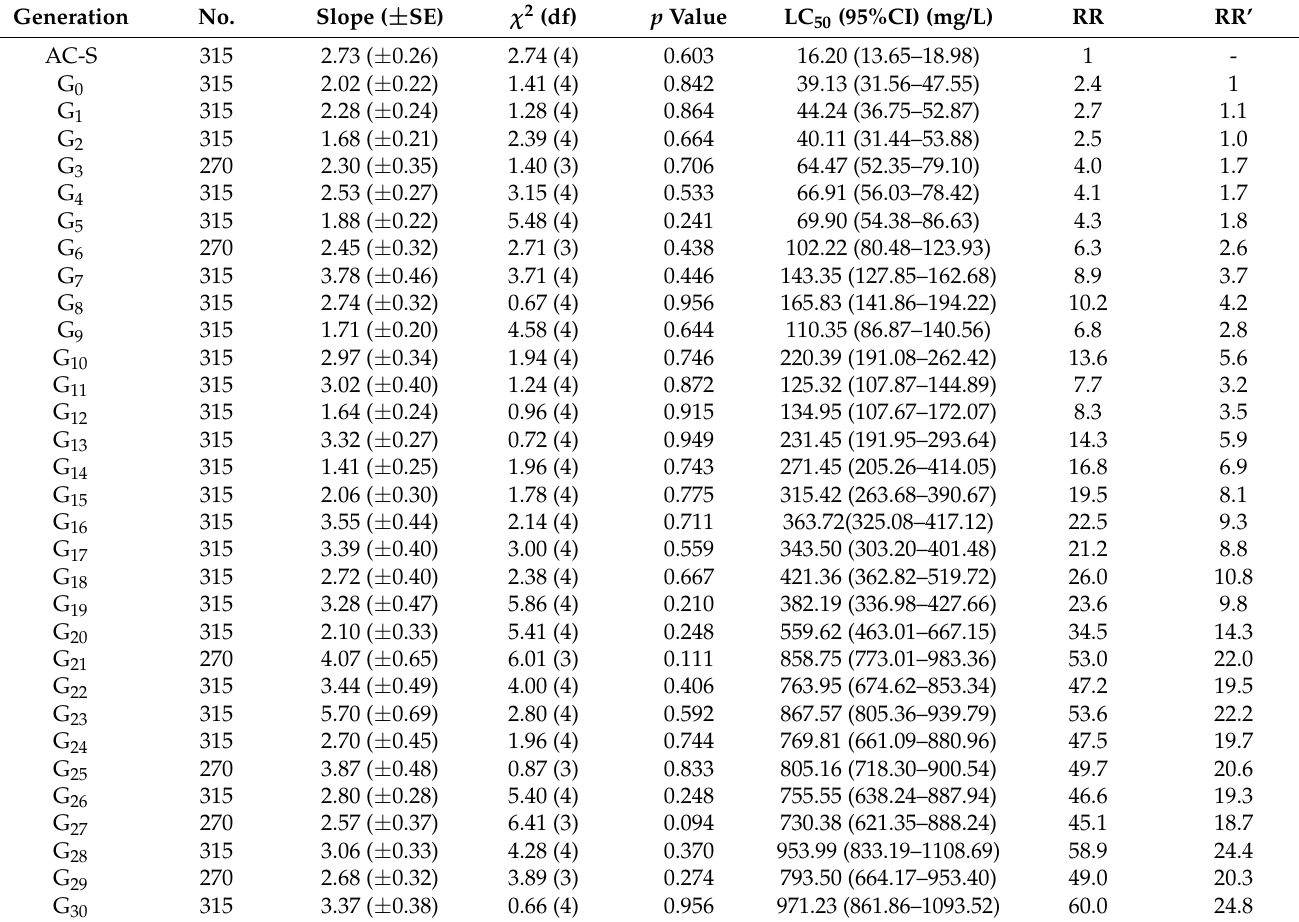
Table 1. The resistance levels of N. lugens to acetamiprid during the selection